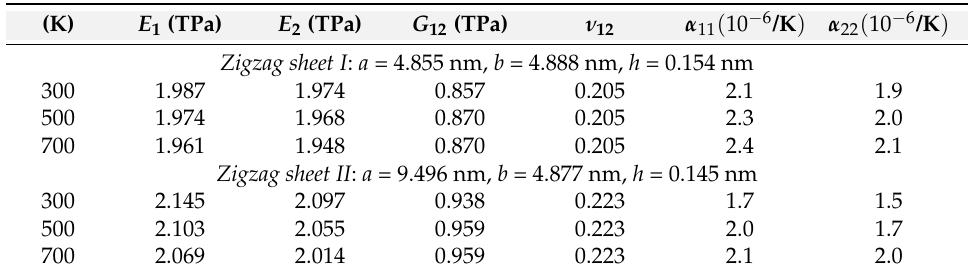
Table 1. Thermo-mechanical properties of the material